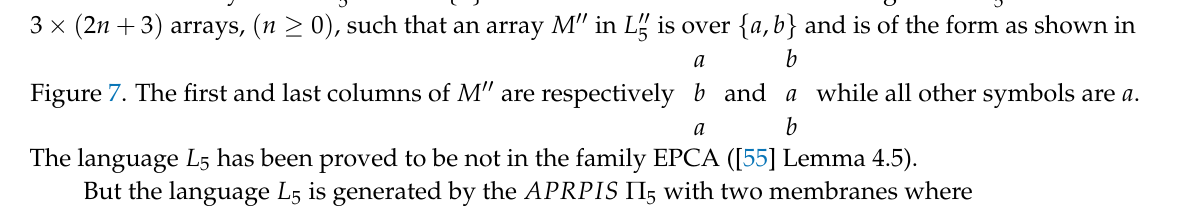
Figure 7. The first and last columns of M (cid:48)(cid:48) are respectively